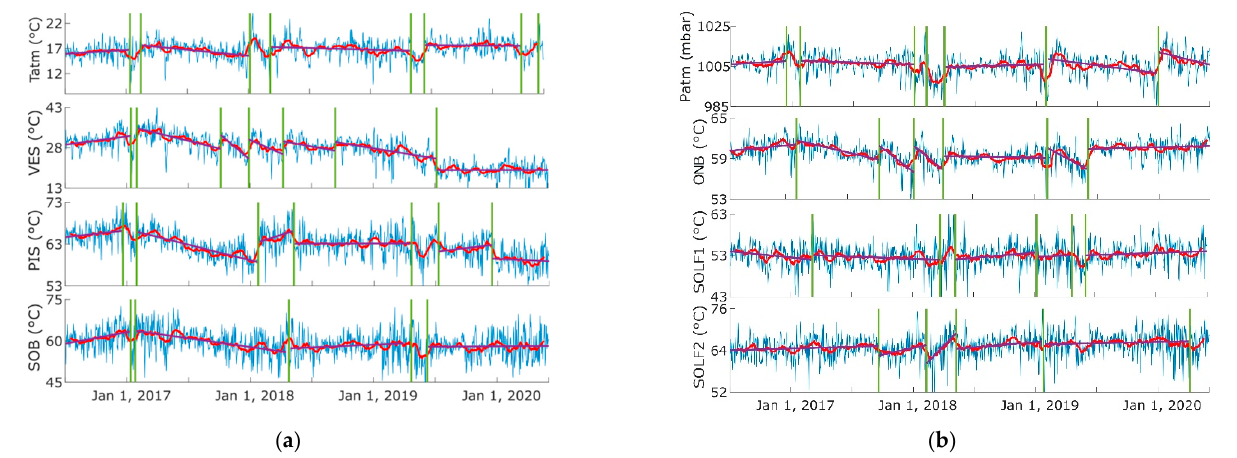
Figure 5. CPs analysis of TIR time-series and atmospheric temperature ( a ) and pressure ( b ) (blue lines). The red lines are the moving average (31 days). The vertical green lines mark the CPs. The trends between two consecutive CPs are represented by purple lines.